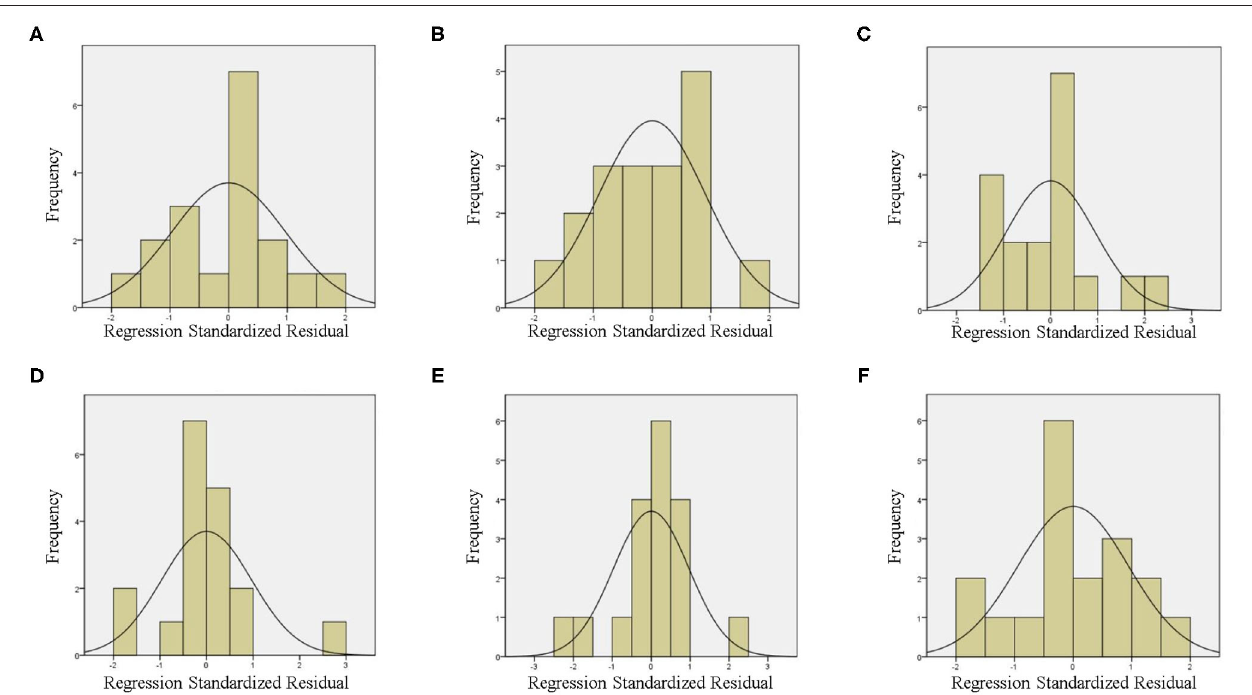
FIGURE 4 | Histogram of the regression standardized residuals of the dependent variable in Wuhan (A) , Xiaogan (B) , Huanggang (C) , Suizhou (D) , Jingzhou (E) , and Huangshi (F) .